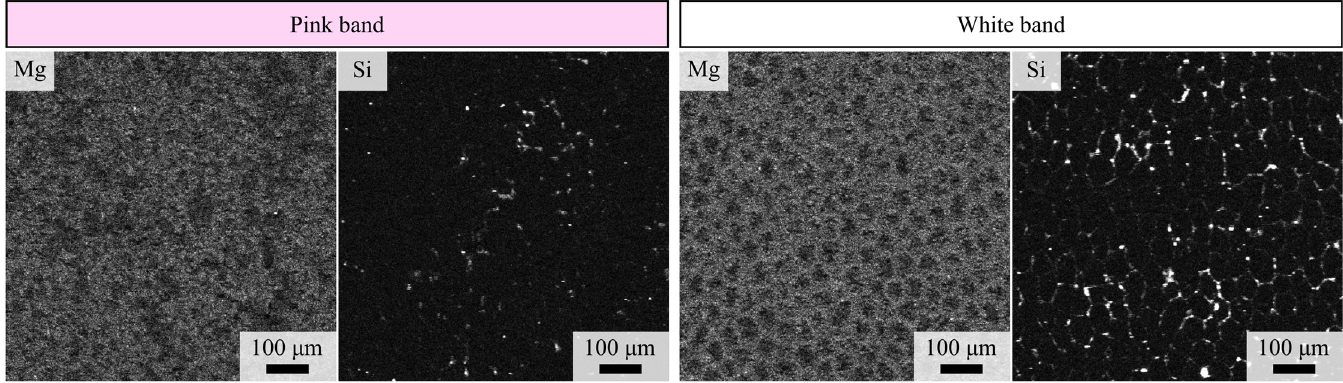
Fig 2. Electron Microprobe images of UOM-232. The Mg and Si is concentrated in the cell walls and highlights the much better cellular preservation in the white bands compared to the pink bands. White represents high abundances and black represents low abundances.